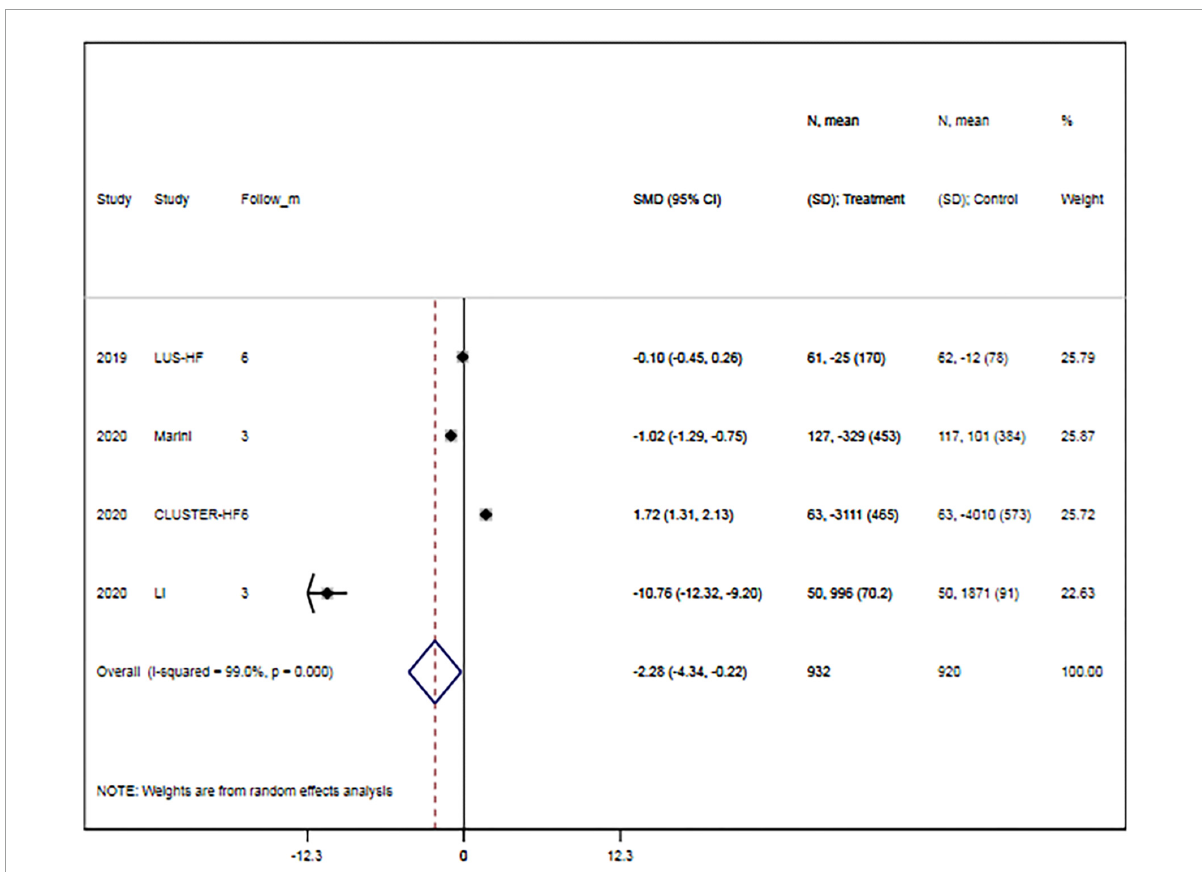
FIGURE5 Lung ultrasound-guided treatment is associated with a lower N-terminal pro-B-type natriuretic peptide concentration. Random-effects model ( I 2 = 99.0%). LUS, lung ultrasound; NT-proBNP, N-terminal pro-B-type natriuretic peptide; SMD, standardized mean difference; CI, confidence